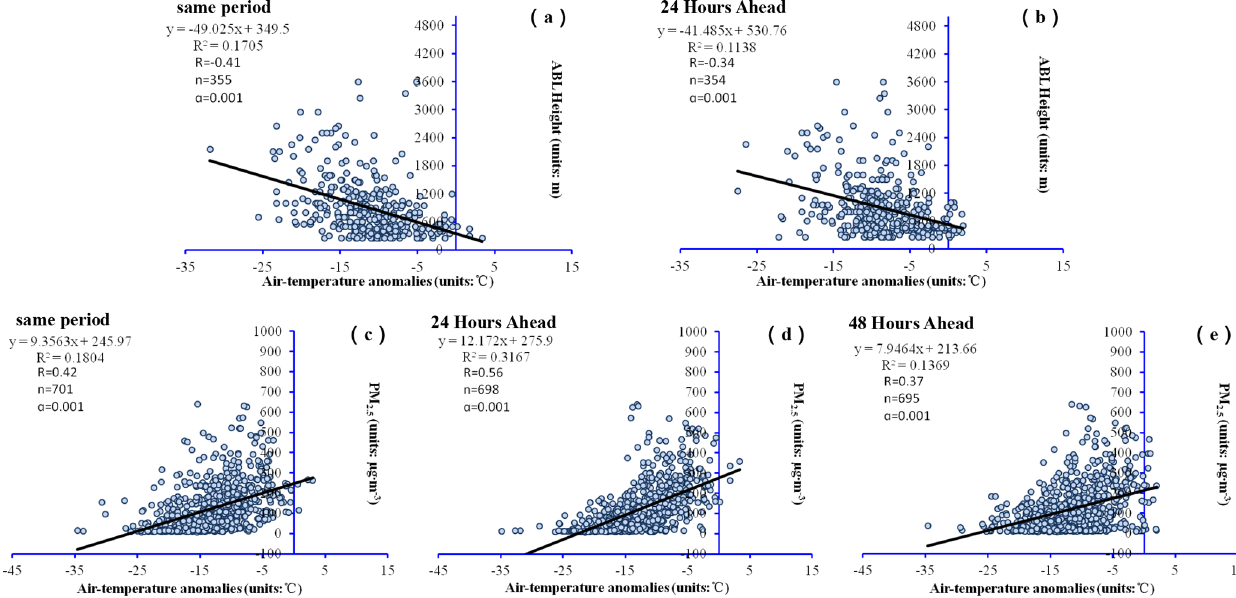
Figure 2. The correlations between ABL height and air temperature anomalies in Beijing during winters from 2014–2017 (a) in the same period at 800hPa and (b) 24h ahead at 650hPa. The correlations between PM 2 . 5 concentration and air temperature anomalies in Beijing during winters from 2014–2017 (c) in the same period at 850hPa, (d) 24h ahead at 800hPa and (e) 48h ahead at 724hPa.